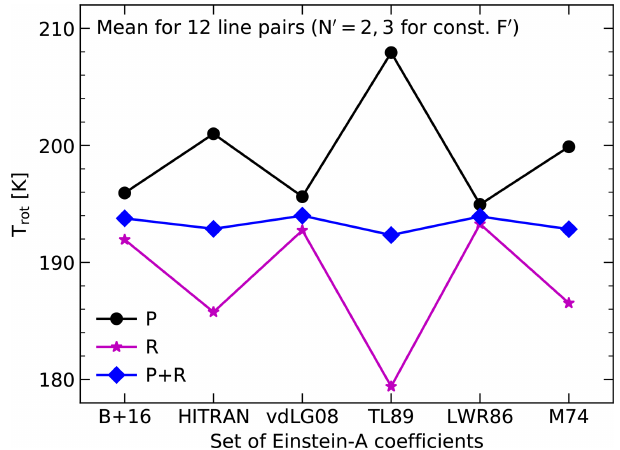
Figure 7. Rotational temperature T rot in kelvins for six sets of Einstein- A coefficients (see Fig. 5). The plotted mean temperatures were derived from 12 pairs of OH lines with fixed electronic sub- state F (cid:48) originating from the second and third rotational upper-level N (cid:48) . The branch was either P (circles) or R (stars). The diamonds show the resulting T rot for a combination of the y(E (cid:48) ) regression slopes for both branches (mean of inverse T rot